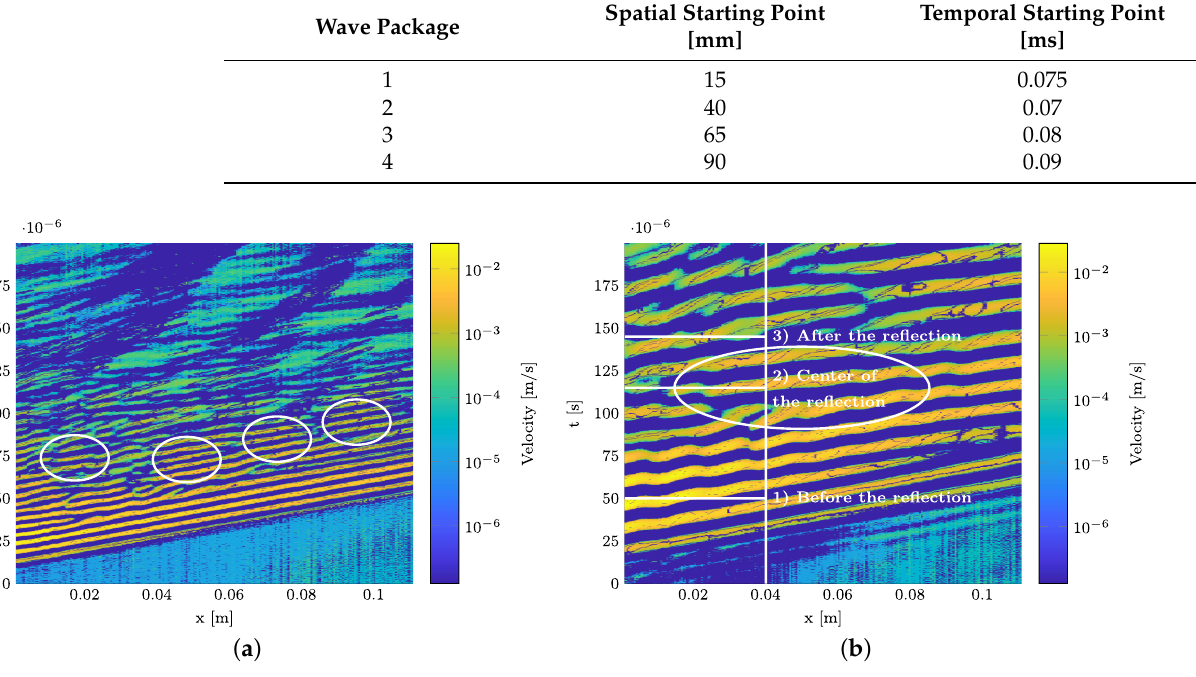
Figure 12. Marked periodic reflections of the S 0 -mode in the B-scan generated using 3D LDV measurement. ( a ) 200kHz. ( b )